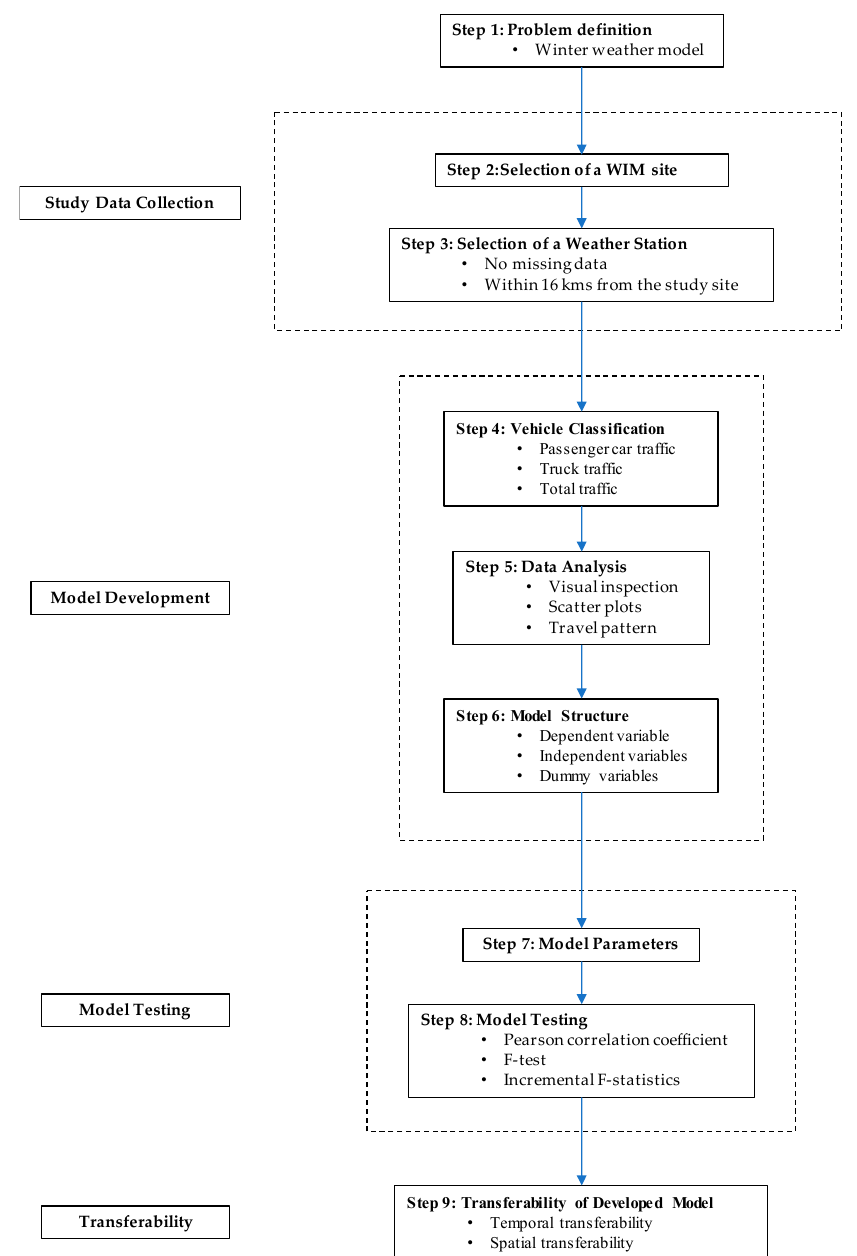
Figure 1. A diagram of the methodology adopted at each step.